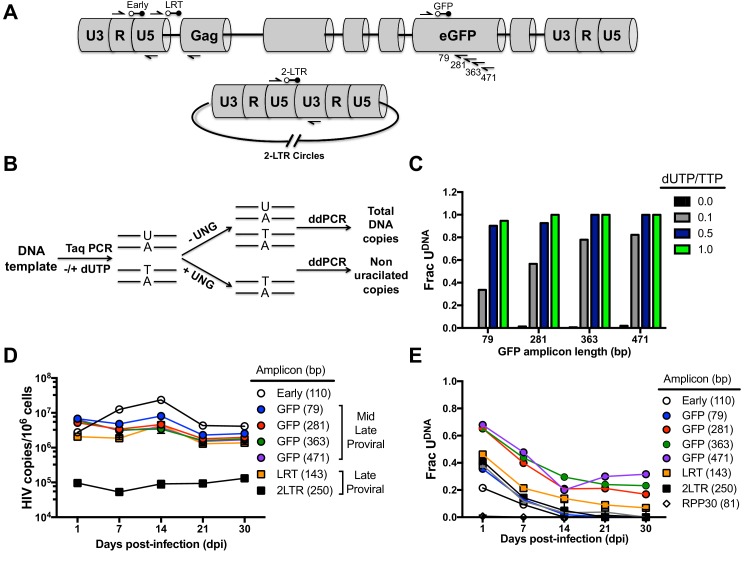
In vitro generated calibration curves for evaluating uracil content in DNA amplicons and single-round HIV infections of cultured MDMs.(A) ddPCR primer and probe locations relative HIV genome (HIVNL4.3(VSVG)). (B) Generation of uracil-containing duplex DNA of increasing length and ratio of dUTP/TTP was achieved by in vitro DNA polymerization using Taq polymerase in the presence of various ratios of dUTP/TTP. These DNA standards (79 to 471 bp) were analyzed by the Ex-ddPCR method as indicated. (C) The fraction of the DNA amplicons that contained detectable uracil (Frac U) increased with DNA amplicon length as well as the dUTP/TTP ratio used in the initial DNA synthesis. (D) In single-round infections of a mixed population of MDMs with HIVNL4.3(VSVG), the copy number of early, middle and late viral cDNAs were measured over a 30-day culture period using primers specific to different regions of the viral genome (see above). The copy number is normalized to one million MDM target cells. (E) Uracil content was measured in each HIV DNA population using Ex-ALU-gag nested qPCR. Number of experimental replicates (n = 1–3) and errors are reported as mean ± SD.